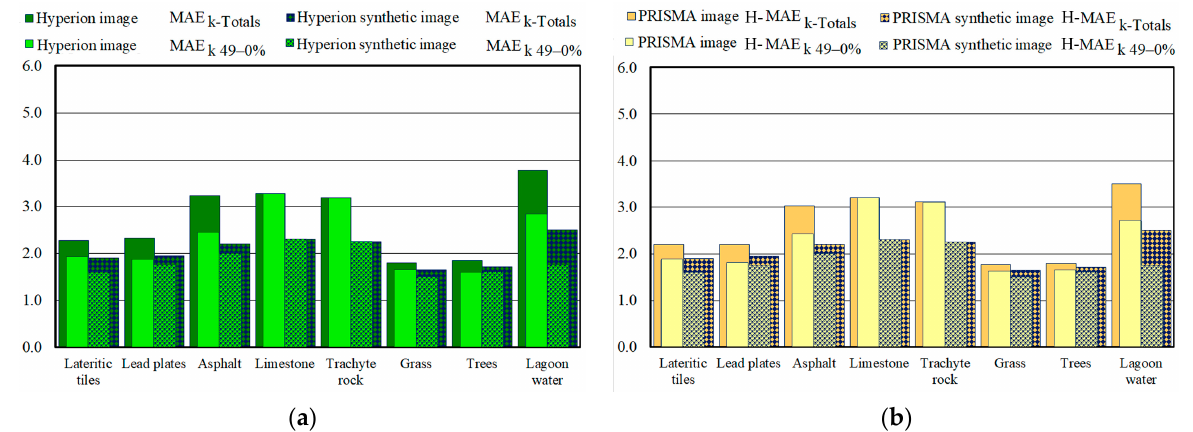
Figure 9. The comparison of the H-MAE k values evaluated from real and synthetic (diamond pattern) images: ( a ) the values obtained from Hyperion images; ( b ) the values obtained from PRISMA images.